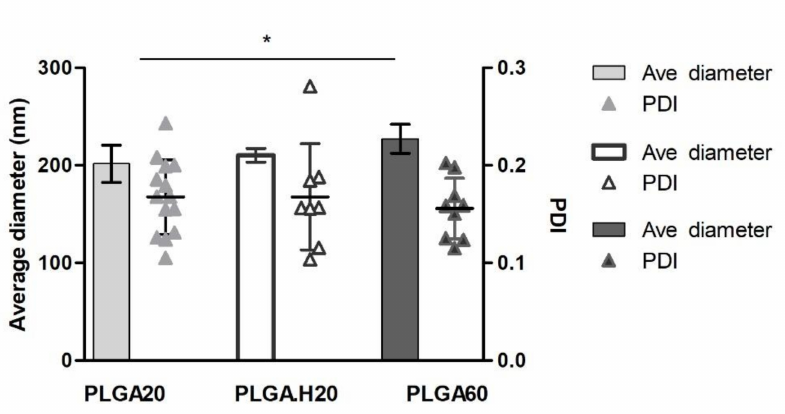
Figure 1. Characterization of poly(lactide- co -glycolide) (PLGA) nanoparticles by average diameter and polydispersity index (PDI) ( n = 3, measured in